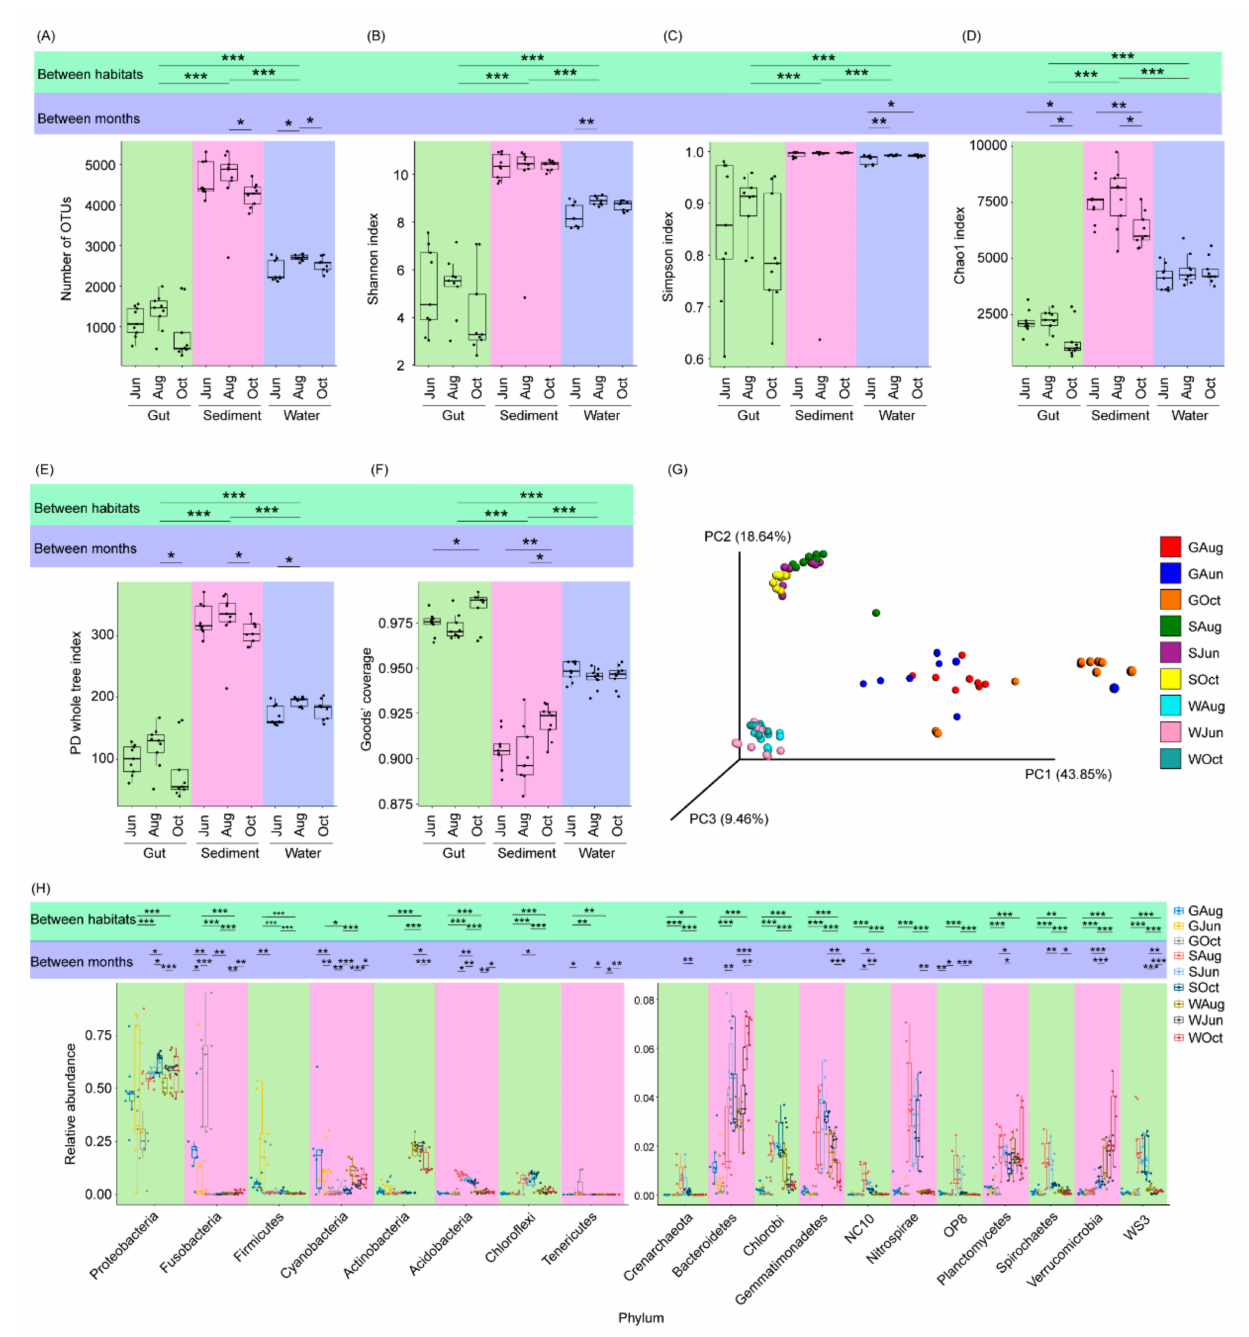
Figure 2. Differences between the microbiota of pond water, sediment, and the largemouth bass gut. ( A ) number of OTUs in the microbiota; ( B ) Shannon index of the microbiota; ( C ) Simpson index of the microbiota; ( D ) Chao1 index of the microbiota; ( E ) PD whole tree index of the microbiota; ( F ) Good’s coverage of the samples; ( G ) Principal coordinate analysis profile of the microbiota; and ( H ) relative abundances of the dominant phyla in the microbiota. *, p < 0.05; **, p < 0.01; ***, p < 0.001. With the exception of a few OTUs, most OTUs were classified into 68 phyla (three archaeal and 65 bacterial phyla), among which Crenarchaeota, Acidobacteria, Actinobacteria, Bac- teroidetes, Chlorobi, Chloroflexi, Cyanobacteria, Firmicutes, Fusobacteria,